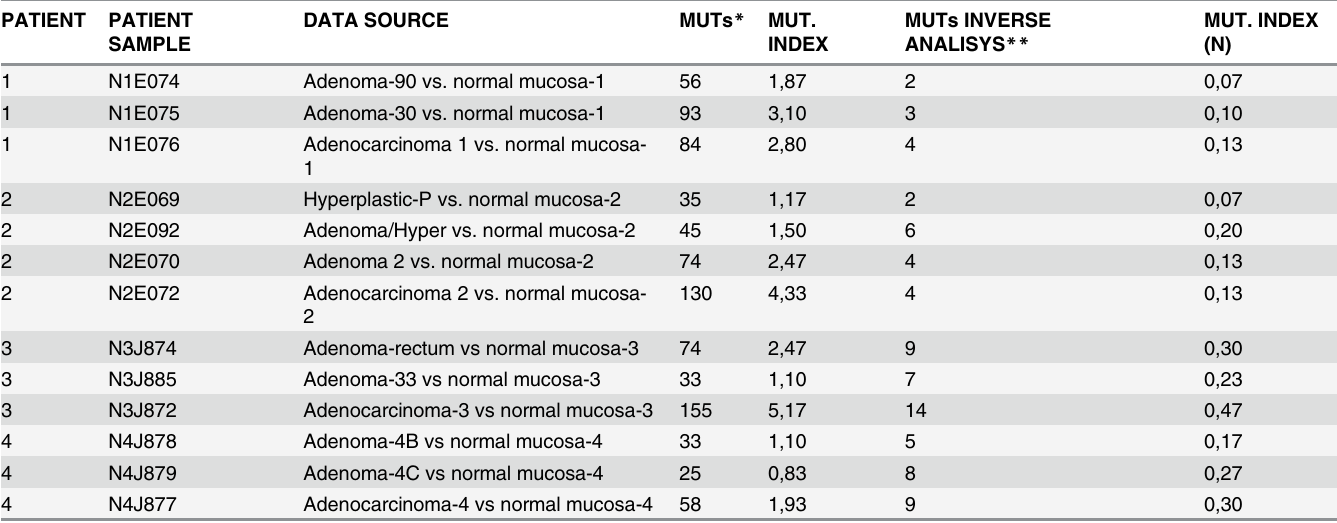
Table 2. Number of unique amino-acid changing mutations found in the primary